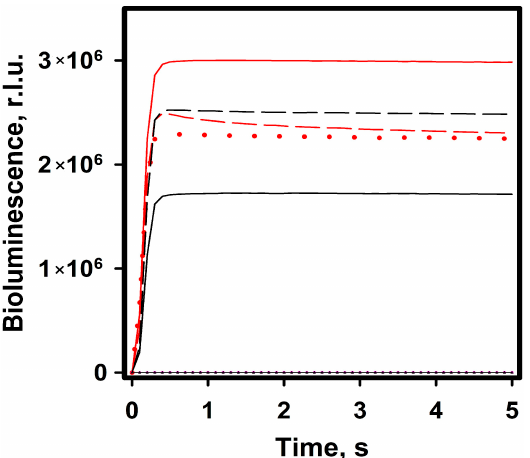
Figure 3. Bioluminescence signal recorded for NanoLuc luciferase with furimazine (red line), FMZ- apoCBP (red dashed line) and FMZ-apoCBP in the absence of Ca 2+ (red point line), CTZ (black line), and CBP (black dashed line) at equal concentrations (100 nM). NanoLuc luciferase concentration was 1 nM in all experiments. The reactions were carried out in 50 mM TrisHCl pH 7.0, 0.1% BSA. Background signals from all substrates are negligible (black point lines). r.l.u.—5 s integral bioluminescence in relative light units.